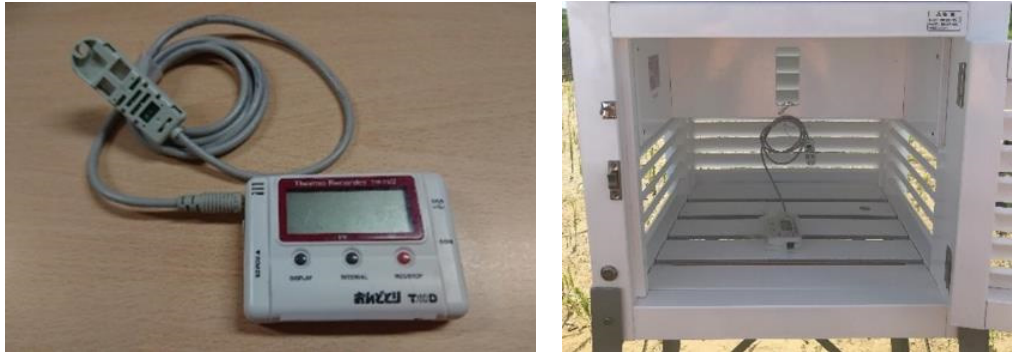
Figure 2. Installation status of the measuring equipment in the louver and temperature and humidity recorder, RH TR-72U. Table 1. Temperature and humidity recorder, and Sendai Local Meteorological Observatory infor- mation, including ID, name, coordinates and distance from the coast in the direction of prevailing winds.